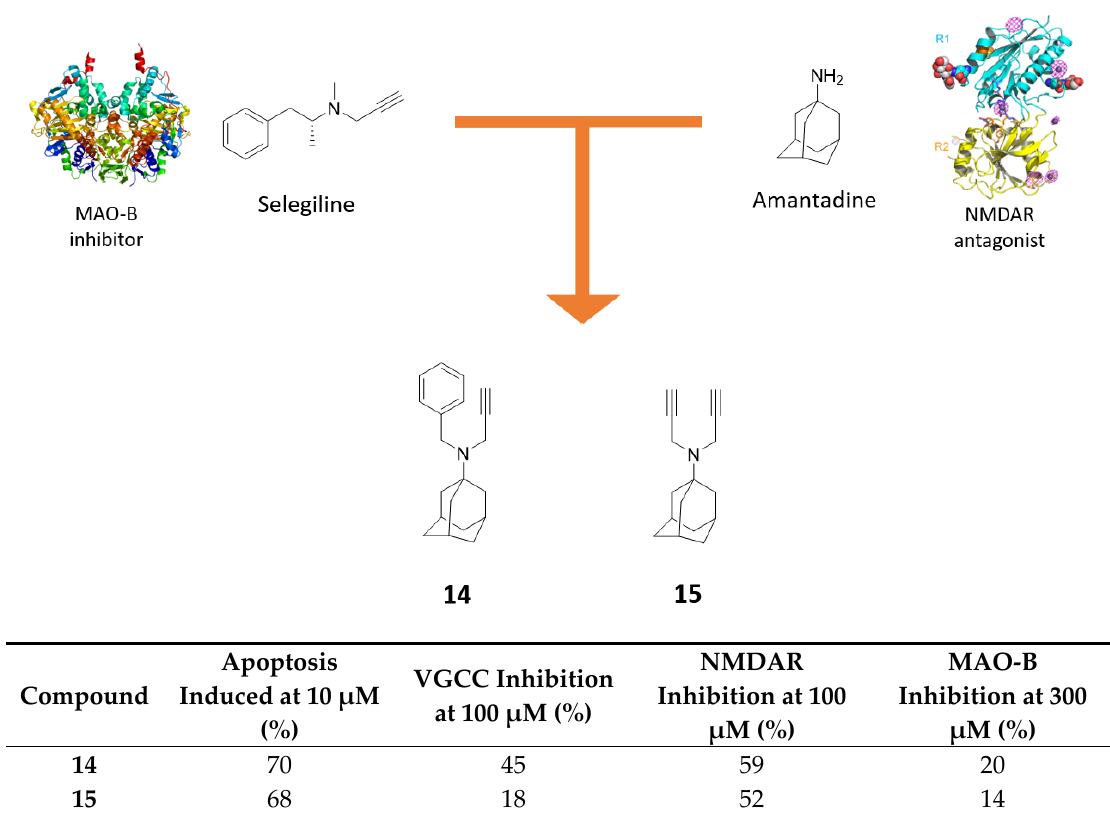
Figure 9. Drug design and biological activities of propargyl-amantadine hybrids 14 and 15 .